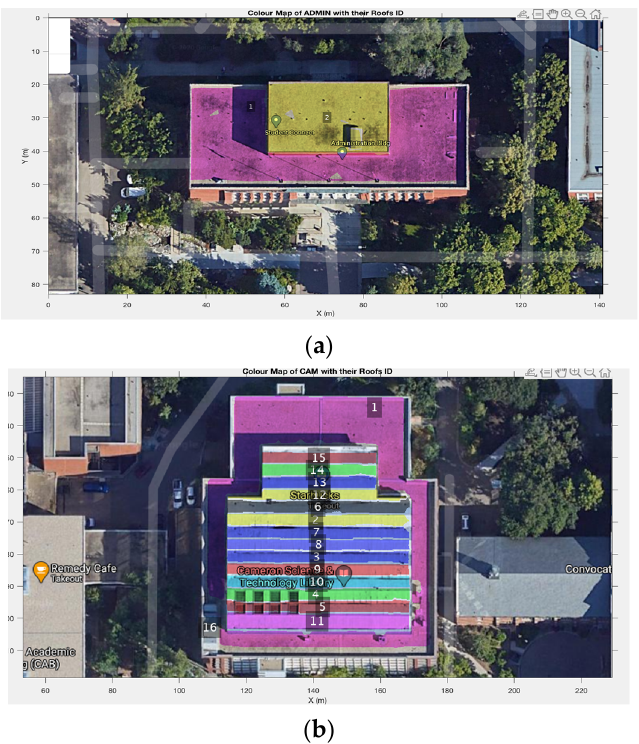
Figure 10. ( a ) Rooftop IDs of the ADMIN building and ( b ) Rooftop IDs of the CAM building.